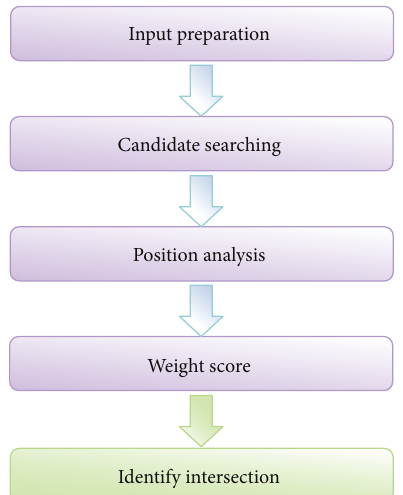
Figure 4: Steps of the proposed MM algorithm to identify the